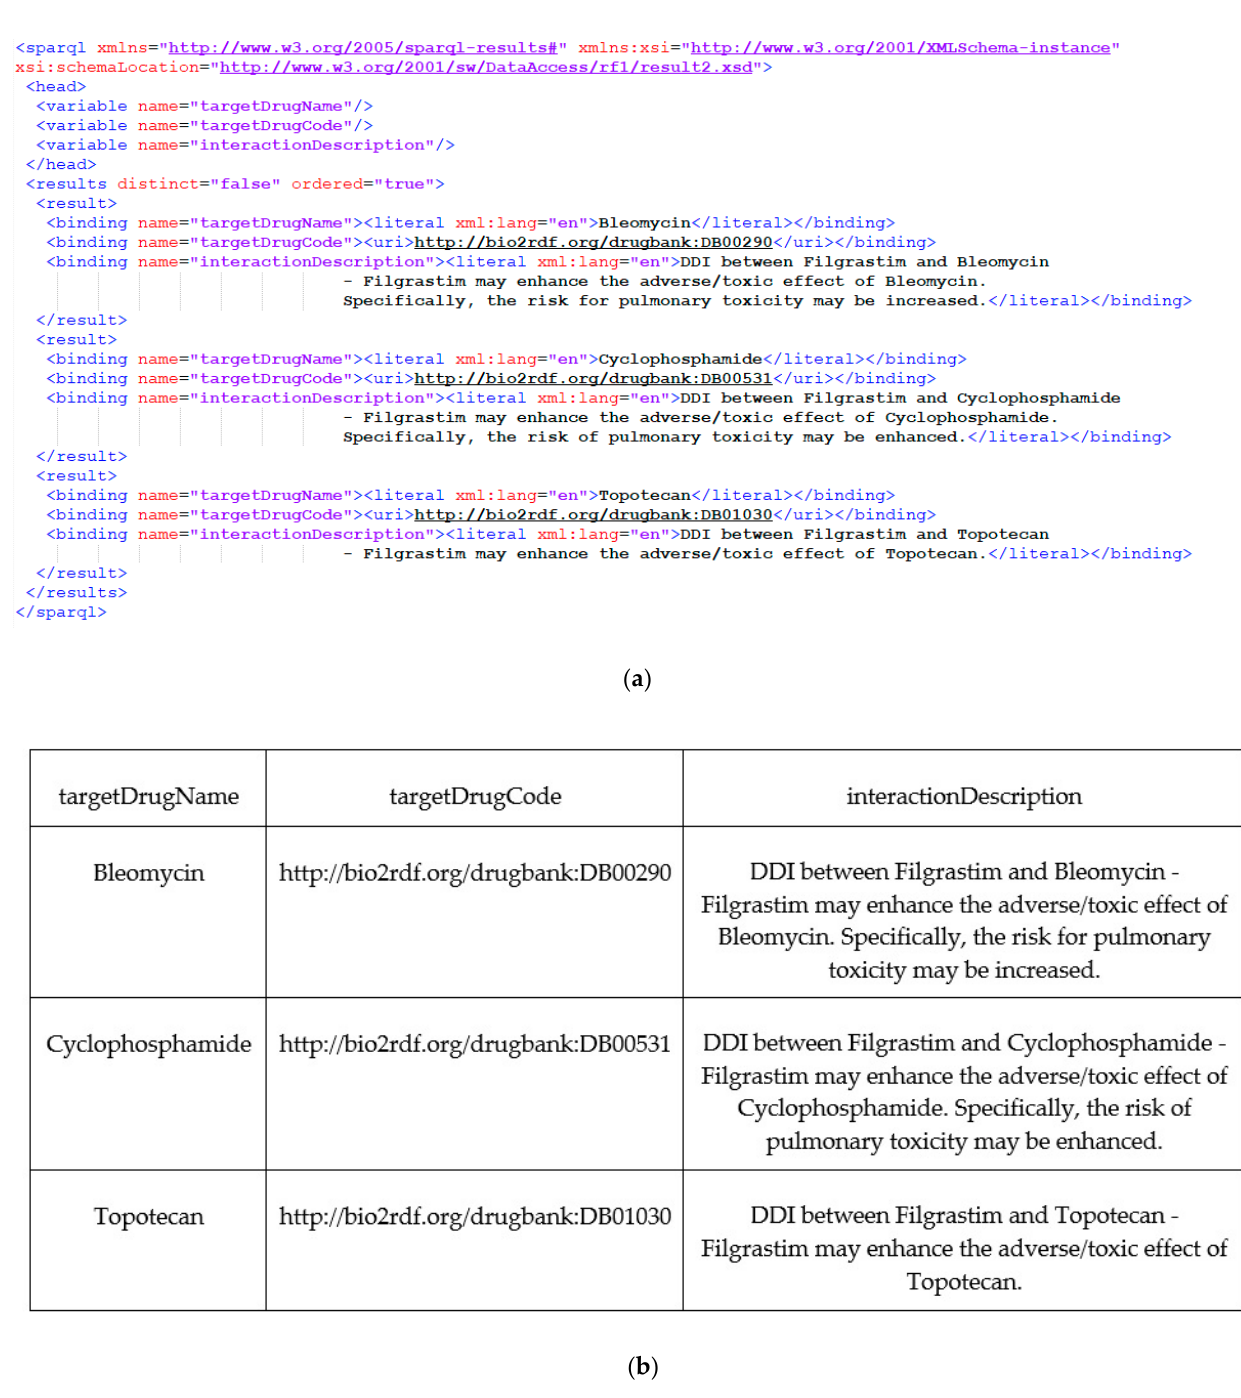
Figure 5. SPARQL query results of the example in section C. These results are the augmentation content. ( a ) The results are formatted in XML according to the canonical W3C schema for query results. ( b ) The results are presented in a table for better understanding.